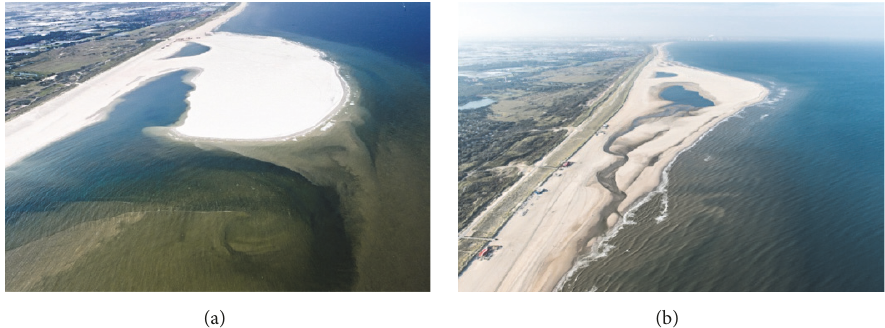
Figure 2: An example of a “Building with Nature” project [3]. On (a), a lot of sand is placed, which is transformed by ecological processes in the area shown in